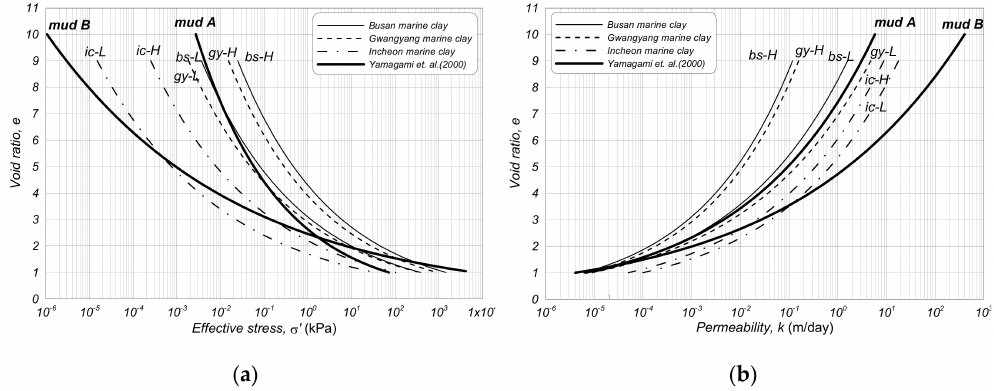
Figure 17. Comparison of our study and the study by Yamagami et al. [15]: ( a ) void ratio vs. e ff ective stress; ( b ) void ratio vs.